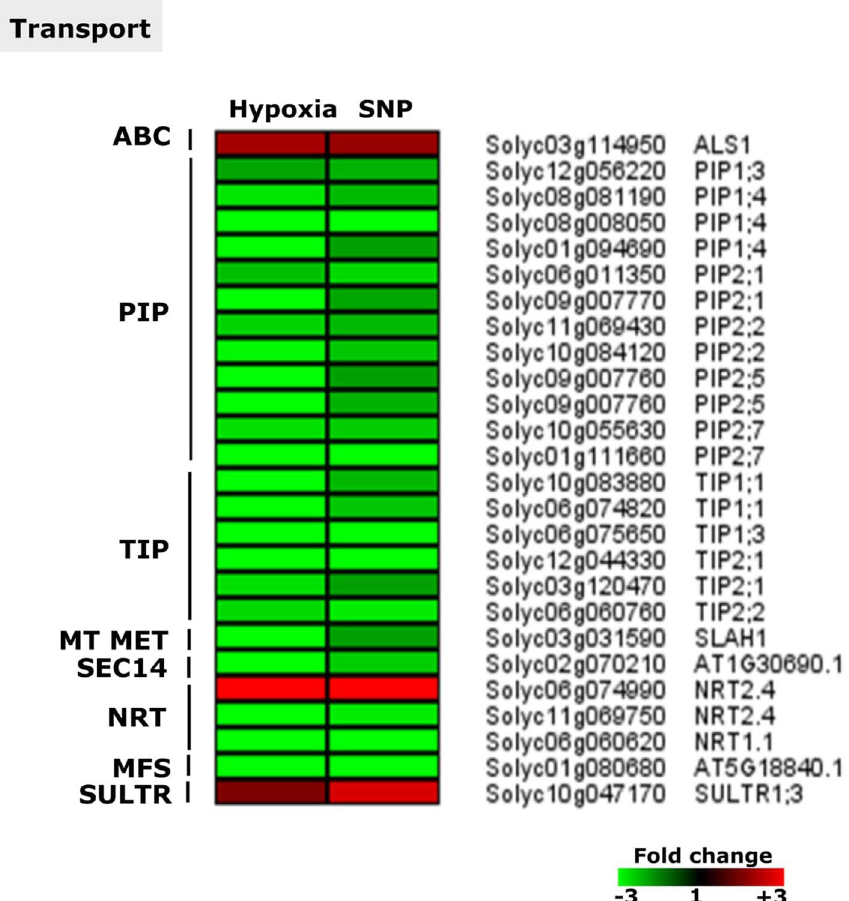
Figure 9. Expression pattern of genes related to cellular transport. Heat map represents the up-regulated (red bars) or down-regulated (green bars) tomato genes and their Arabidopsis thaliana homologs in response to hypoxia and SNP-treatment. Depicted are differentially expressed genes ( Padj < 0.05), ( n = 3). ABC, ATP-binding cassette transporter; PIP, major intrinsic proteins; TIP, tonoplast intrinsic protein; MT MET, metabolite transporters at the mitochondrial membrane, SEC14, Sec14p-like phosphatidylinositol transfer family; NRT, nitrate transporter; MFS, major facilitator superfamily; SULTR, sulfur transporter. ALS1 , ALUMINUM SENSITIVE 1 ; PIP1 ; 3 , PLASMA MEMBRANE INTRINSIC PROTEIN 1 ; 3 ; PIP1 ; 4 , PLASMA MEMBRANE INTRINSIC PROTEIN 1 ; 4 ; PIP2 ; 1 , PLASMA MEMBRANE INTRINSIC PROTEIN 2 ; 1 ; PIP2 ; 2 , PLASMA MEMBRANE INTRINSIC PROTEIN 2 ; 2 ; PIP2 ; 5 , PLASMA MEMBRANE INTRINSIC PROTEIN 2 ; 5 ; PIP2 ; 7 , PLASMA MEMBRANE INTRINSIC PROTEIN 2 ; 7 ; TIP1 ; 1 , TONOPLAST INTRINSIC PROTEIN 1 ; 1 ; TIP1 ; 3 , TONOPLAST INTRINSIC PROTEIN 1 ; 3 ; TIP2 ; 1 , TONOPLAST INTRINSIC PROTEIN 2 ; 1 ; TIP2 ; 2 , TONOPLAST INTRINSIC PROTEIN 2 ; 2 ; SLAH1 , SLAC1 HOMOLOGUE 1 ; NRT2.4 , NITRATE TRANSPORTER 2.4 ; NRT1.1 , NITRATE TRANSPORTER 1.1 ; SULTR1.3 , SULFATE TRANSPORTER 1.3